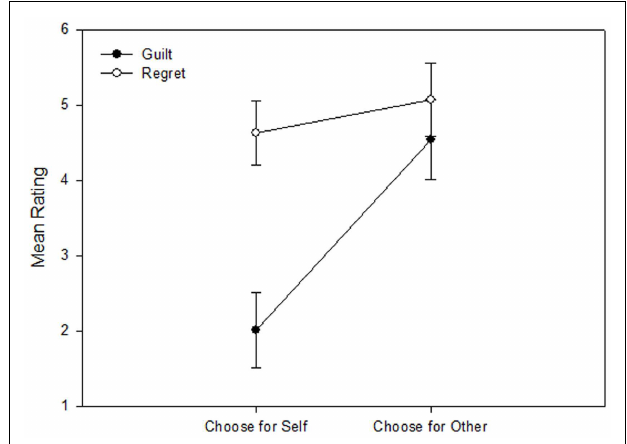
FIGURE 2 | Ratings of guilt and regret (means ± SEM) after negatively valenced outcomes when subjects had chosen a lottery for themselves (“self” condition = intrapersonal/non-social) or for Anastasia (“other” condition = interpersonal/social). Guilt but not regret predominantly occurs in the interpersonal context.